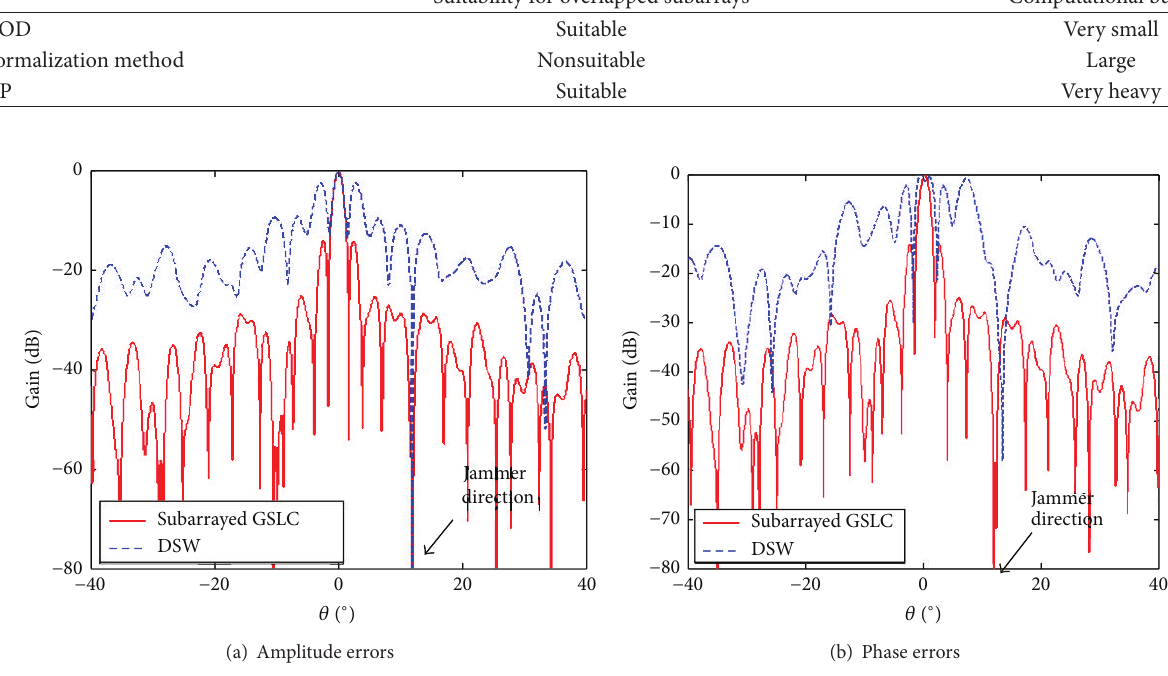
Figure 2: Adaptive patterns with I/Q